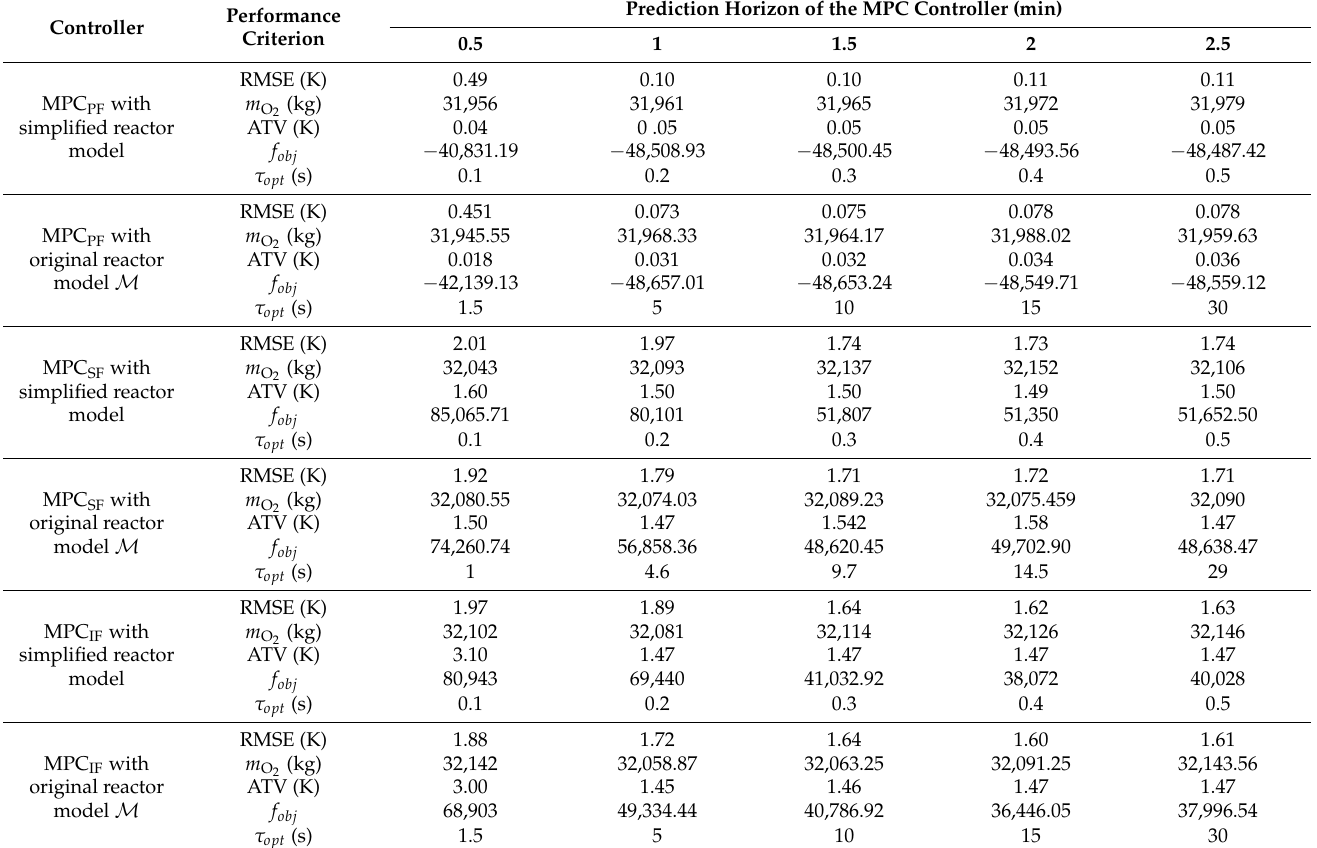
Table 5. MPC evaluation: simplified reactor model vs. original reactor model M for the three types of DNI forecasts (7-day simulation). RMSE is the root mean squared error. m O oxygen injected in the reactor. ATV is the average temperature variation. f obj is the objective function value. τ opt is the mean optimization time per time